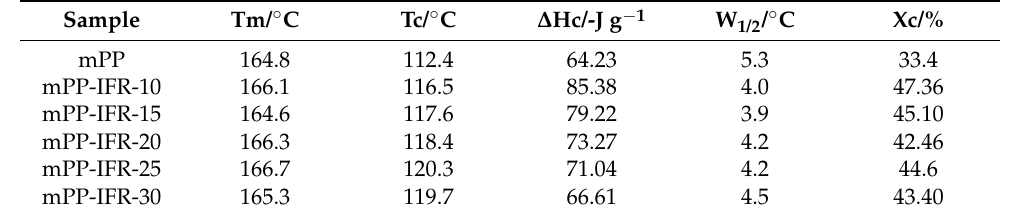
Figure 2. The heating ( a ) and cooling ( b ) DSC curves of the fibers. Table 2. The DSC data of the different fibers.